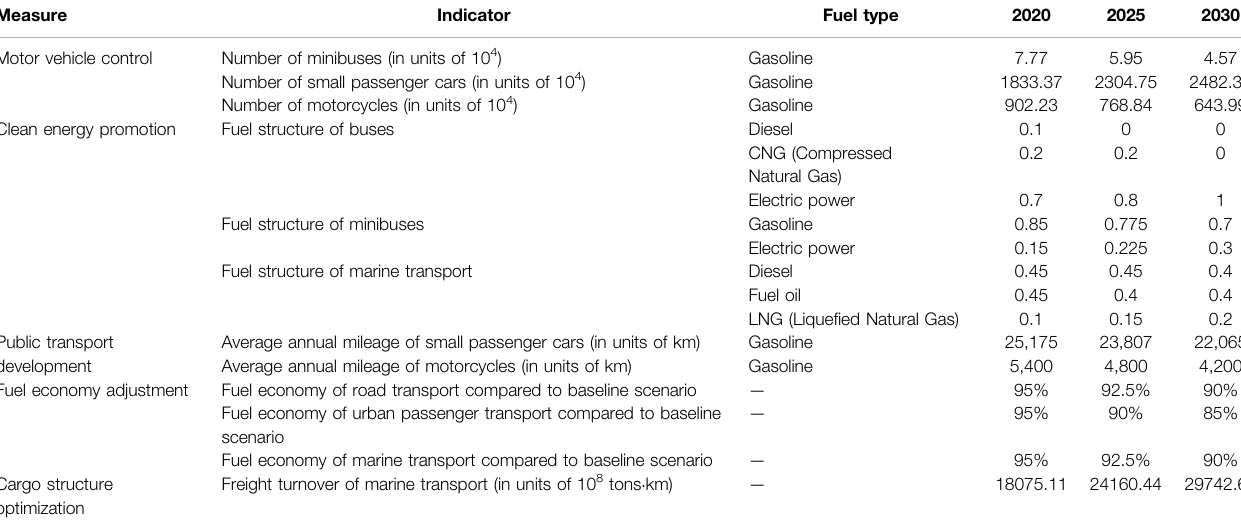
TABLE 2 | Speci fi c quantitative indicators of future transportation in Guangdong Province under low-carbon